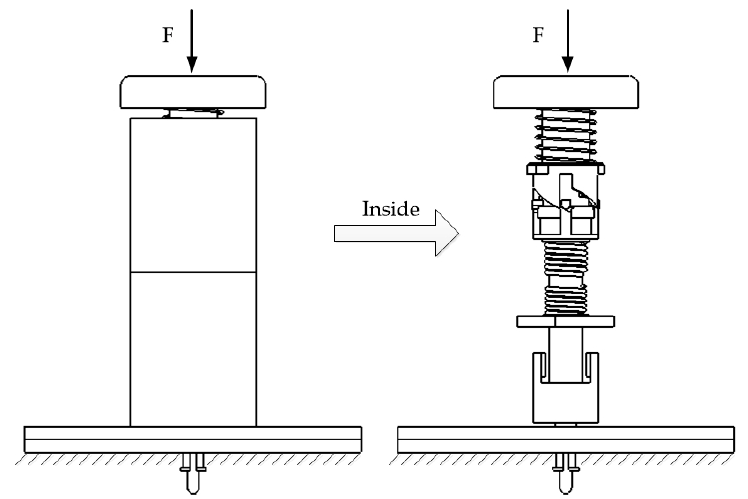
Figure 9 . Critical state of temporary fastener.